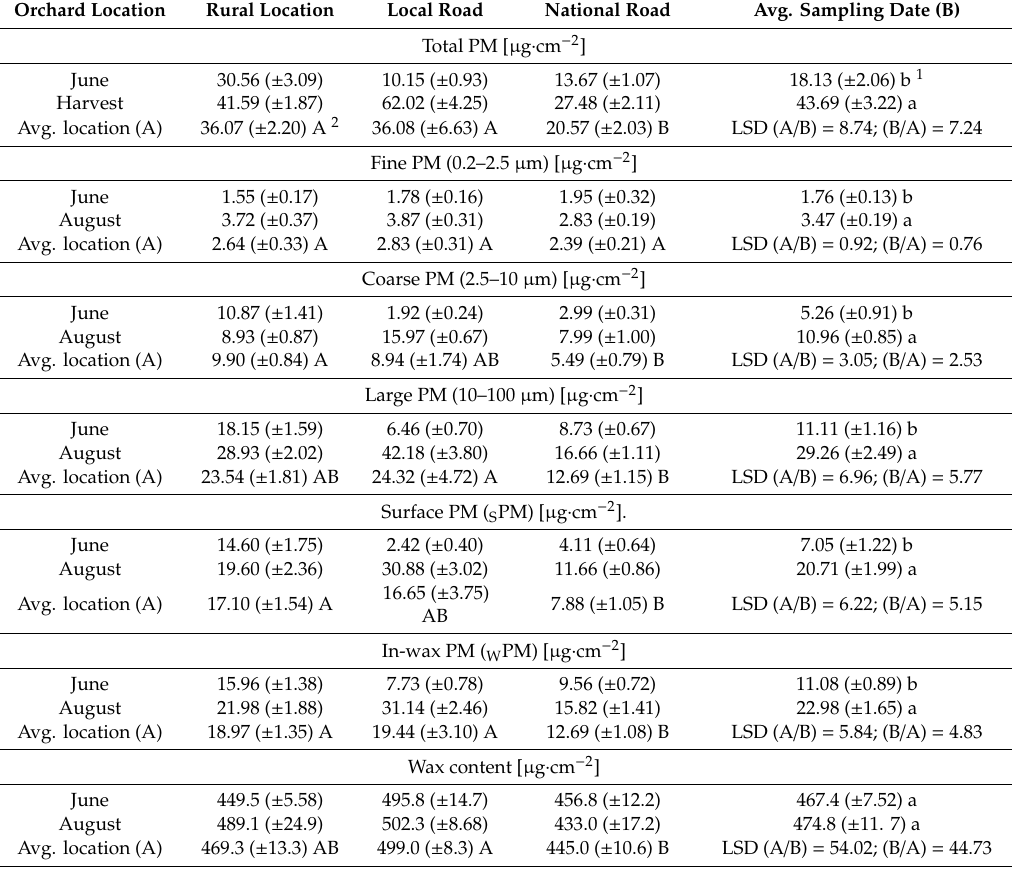
Table 7. E ff ect of orchard location (proximity to roads with di ff erent tra ffi c intensity) and sampling date on accumulation of total PM (0.2–100 µ m), fine PM (0.2–2.5 µ m), coarse PM (2.5–10 µ m), large PM n = 9 (3 replications × 3 distances to road), 18 (average for location: 3 replications × 3 distances to road × 2 sampling dates) and 27 (average for sampling date: 3 replications × 3 locations × 3 distances to road).